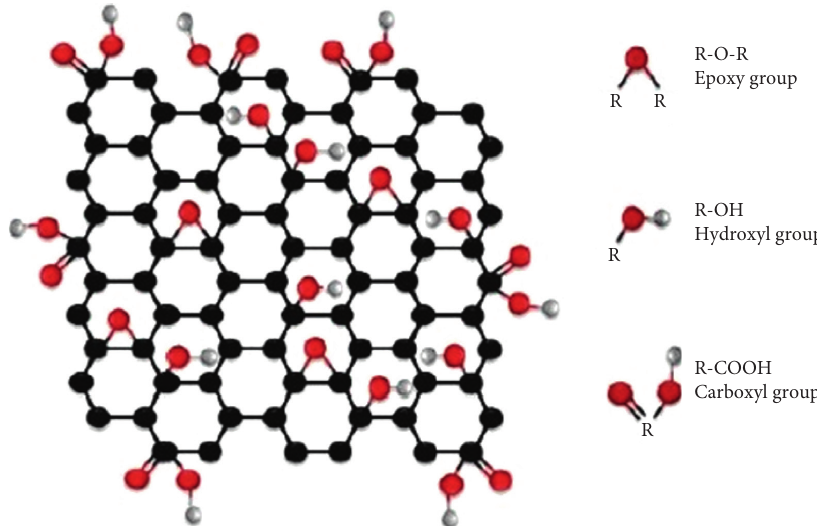
Figure 1: The structure of GO with functional groups